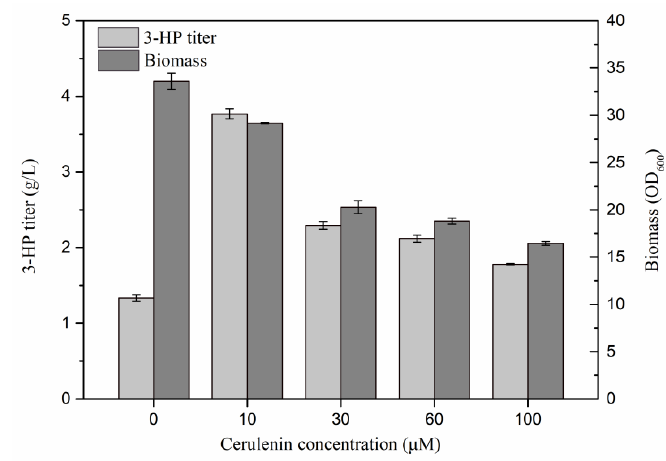
Figure 4. 3-HP titers and biomass (OD 600 ) of strain Cgz5 grown in a medium comprising 15 g/L glucose and 5 g/L acetate with different cerulenin concentrations at 48 h. Error bars indicate the standard deviations from three independent cultures.